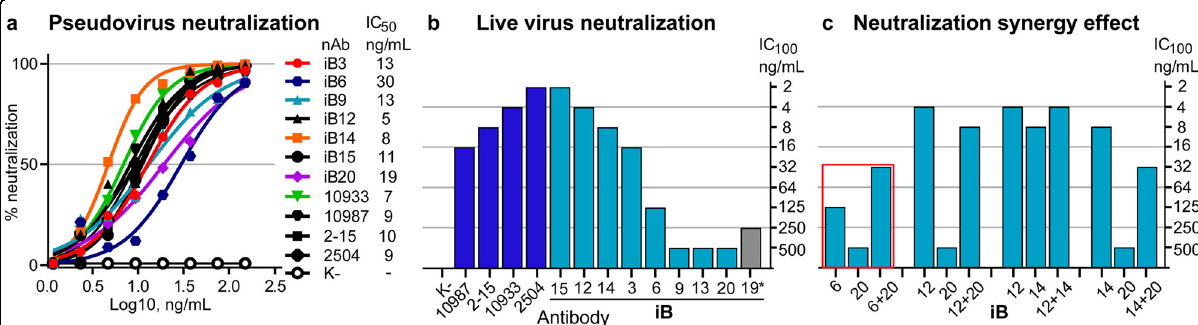
Fig. 3 In vitro virus neutralization by the SARS-CoV-2 nAbs. Pseudovirus ( a ) or live ( b , c ) SARS-CoV-2 virus were used. nAbs were either published before (dark blue columns) or obtained in this study (cyan). iB19* neutralization was incomplete (gray). glVRC01 is an irrelevant HIV-speci fi c antibody. 10933, REGN10933; 10987, REGN10987; 2-15, COVA2-15; 2504, COV2-2504. Antibody pair (iB6 + iB20) displaying synergistic activity is marked by a red frame ( c